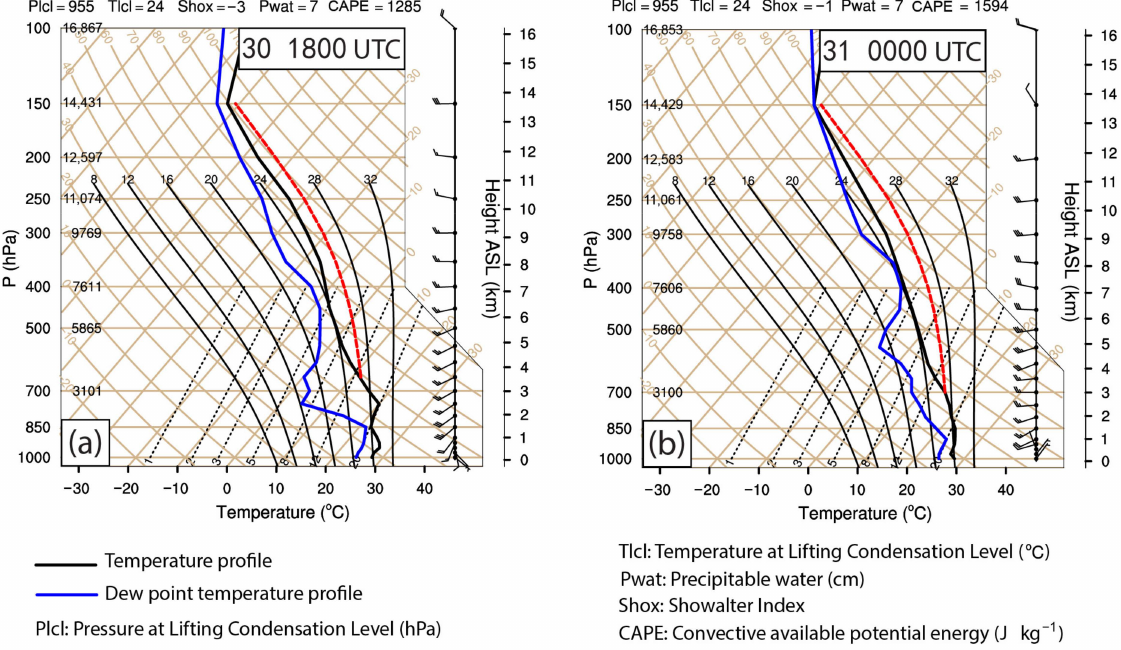
Figure 6. ( a ) Skew T-logP diagram derived from the NCEP FNL data (the location is marked with symbol “ (cid:73) ” in Figure 1) at 1800 UTC 30 July 2010; ( b ) is the same as ( a ) but for the time at 0000 UTC 31 July